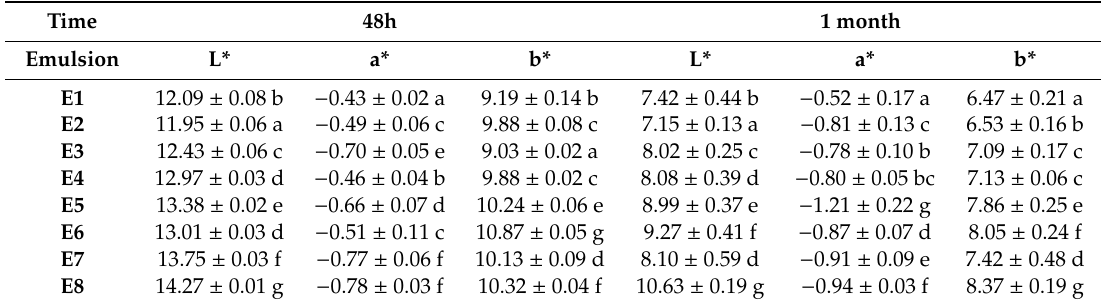
Table 4. CIELAB L*, a*, b* values of the emulsions stored 30 days at 5 ◦ C (as a mean value of 3 determinations ±